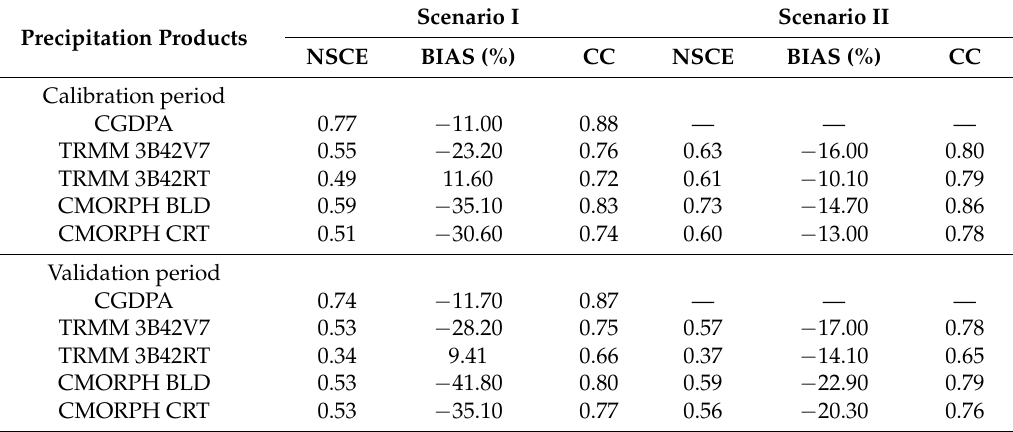
Figure 11. Comparison of observed and simulated monthly discharge in Scenario I from ( a ) CGDPA, ( b ) 3B42V7, ( c ) 3B42RT, ( d ) CMORPH BLD and ( e ) CMORPH CRT in both calibration (2006–2009) and validation (2010–2013) periods. Table 4. Comparison of daily observed and simulated streamflow under the two calibration